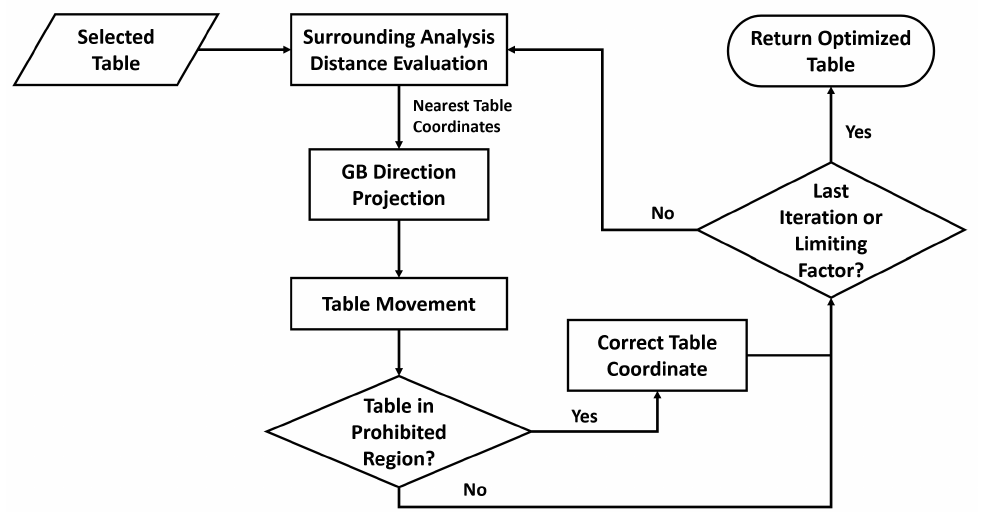
Figure 5. Flux diagram of the GBLS procedure, the number of maximum iterations is determined from the LS